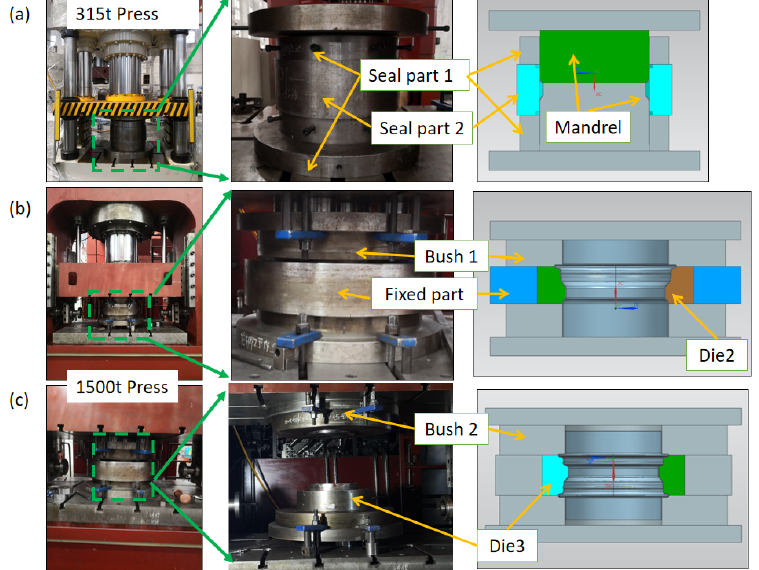
Figure 7. Experimental setup and dies: ( a ) external pressure forming stage, ( b ) one side of internal pressure forming stage, and ( c ) other side of internal pressure forming stage.